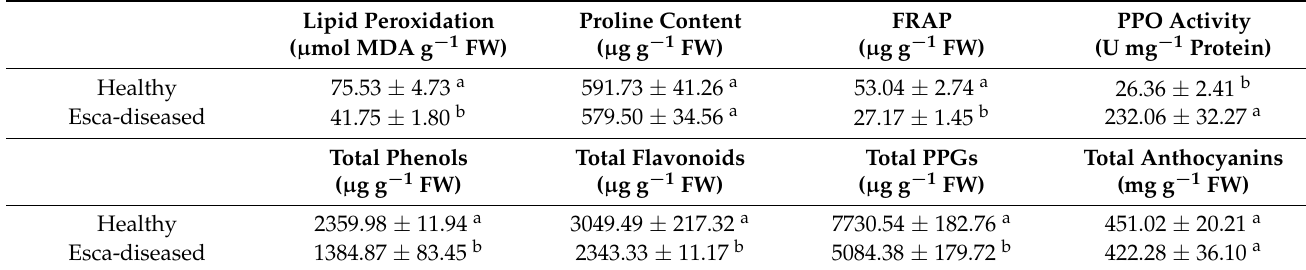
Table 5. Effect of esca on the membrane lipid peroxidation, proline content, antioxidant capacity (FRAP) and PPO activity, total phenols, flavonoids, PPGs, and anthocyanin content in grapes of Vitis vinifera cv.